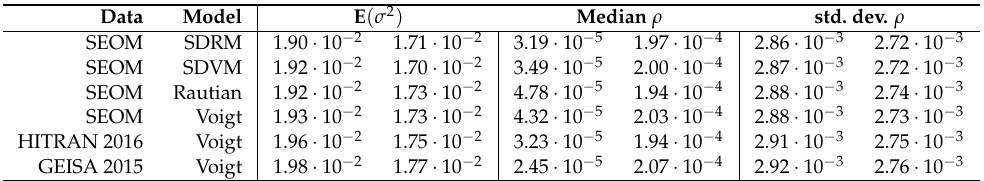
Table 3. Mean of the norm of the spectral fitting residuals along with the median and standard deviation of the residuum vector for various combinations of line data and models in orbit 8663 (left column) and 13212 (right column). Note that for both the speed-dependent Rautian and speed-dependent Voigt profiles, line-mixing was taken into account.